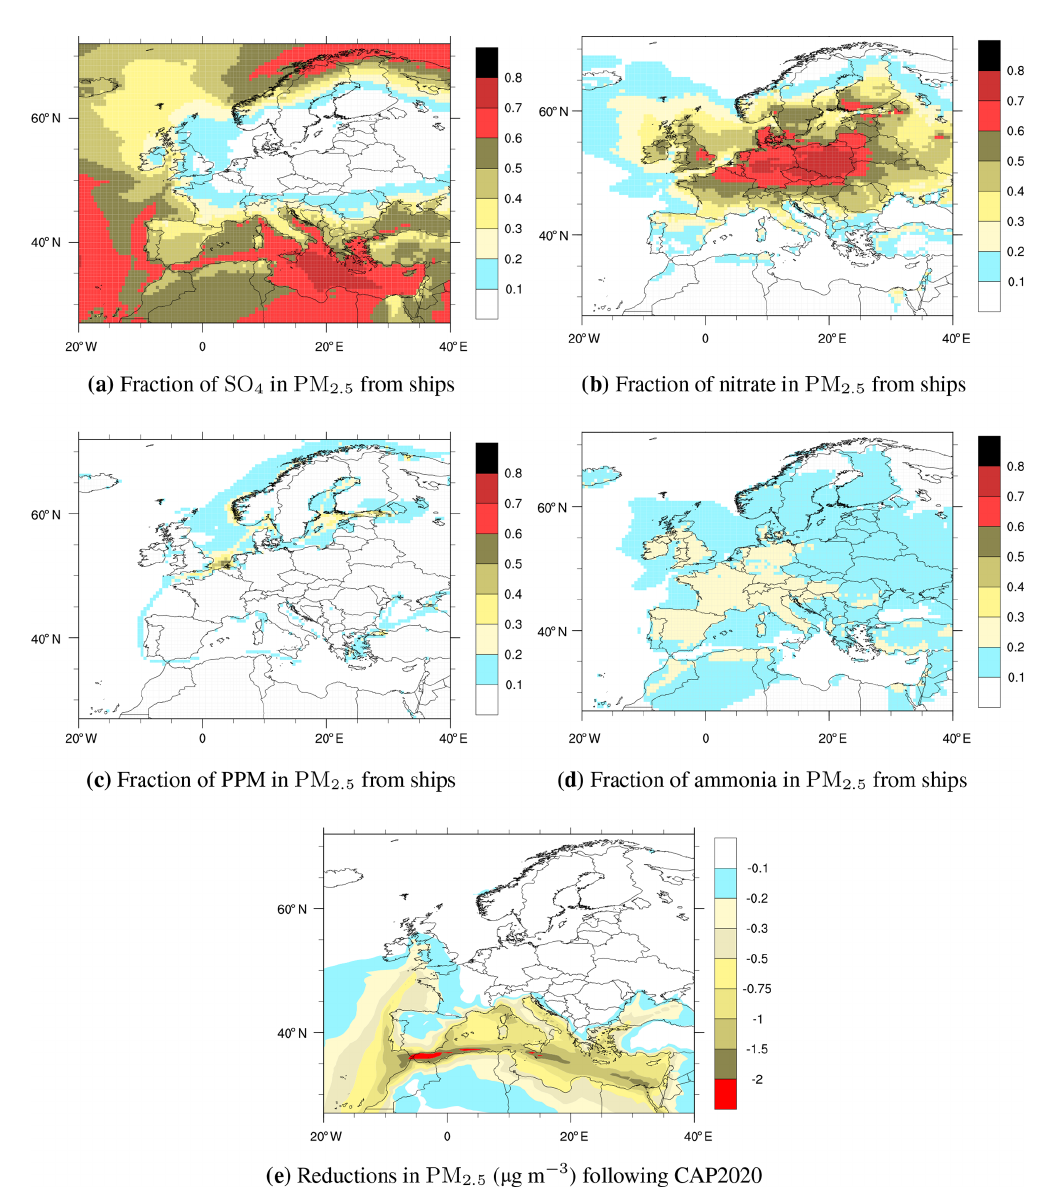
Figure 8. Fraction of (a) SO 4 , (b) nitrate, (c) PPM, and (d) ammonia in PM 2 . 5 in European waters from shipping (a) . PPM are ash, EC, and OC. (e) Reductions in PM 2 . 5 (µgm − 3 ) following the CAP2020 regulations.